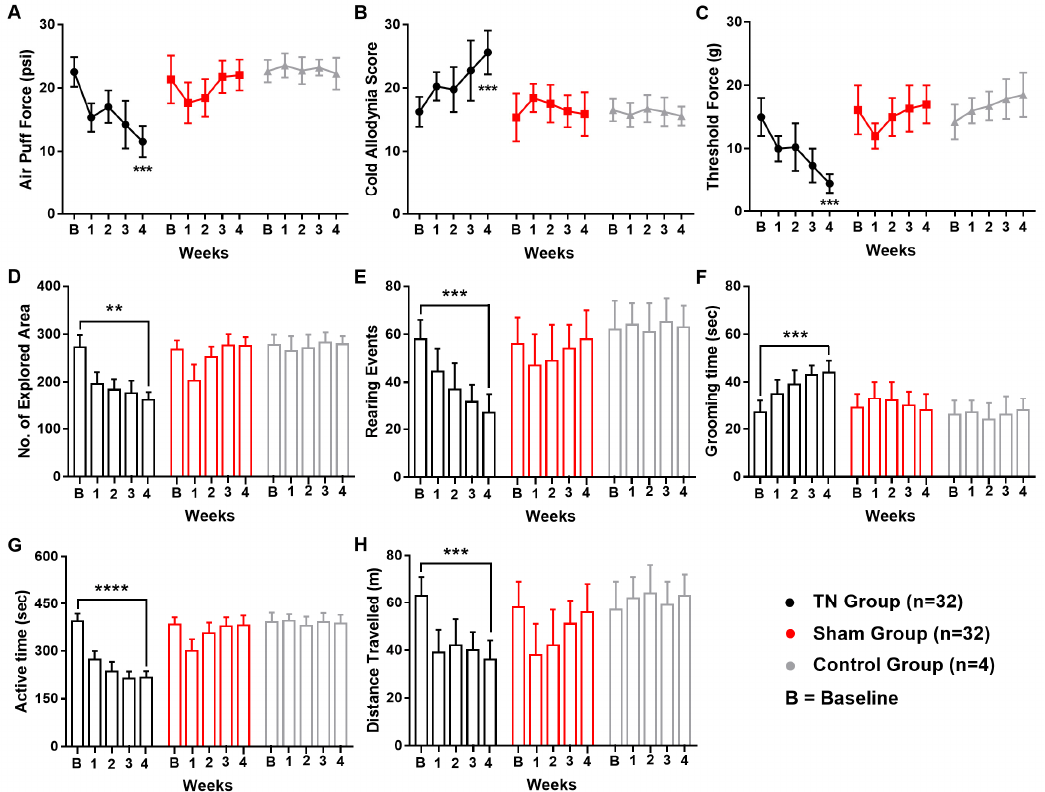
Figure 1. Changes in pain behaviors following ION ligation. Behavioral scores of the TN, sham, and control groups ( A – H ). ( A ) Results from the air-puff test for the ipsilateral trigeminal facial area. ( B ) Cold allodynia score results for the ipsilateral facial area with acetone drops. ( C ) Mechanical allodynia (von Frey test) results for the ipsilateral facial side. ( D–H ) Results of the open field test: ( D ) number of explored areas, ( E ) rearing events, ( F ) grooming time, ( G ) active time, and ( H ) distance traveled. **, p < 0.01; ***, p < 0.001; ****, p < 0.0001, significant difference determined using an analysis of variance. Data are represented as means ± SD.